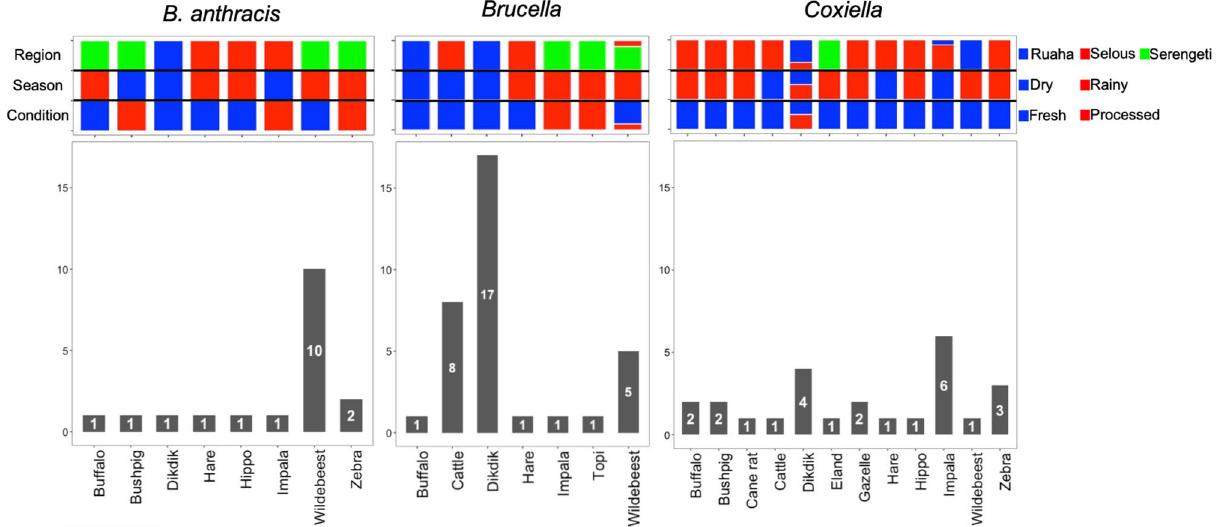
Figure 2. Counts of Bushmeat Samples Positive for Select Agents. The count of positives for each species are included in the bar charts (with the total count in the bar with white font), separated by B. anthracis -positive in the left panel, Brucella -positive in the middle panel, and Coxiella -positive in the right panel. The coloring above the bar graphs show the proportion of samples within the species that are in each category (Region, Season, and Condition). The blue color represents samples collected from Ruaha, collected during dry season, and fresh samples. The red color represents samples collected from Selous, collected during Rainy season, and processed samples. The green color represents samples collected from the Serengeti. For instance, in the B. anthracis panel, one positive fresh (blue) buffalo sample was collected during rainy season (red), from Serengeti region (green).